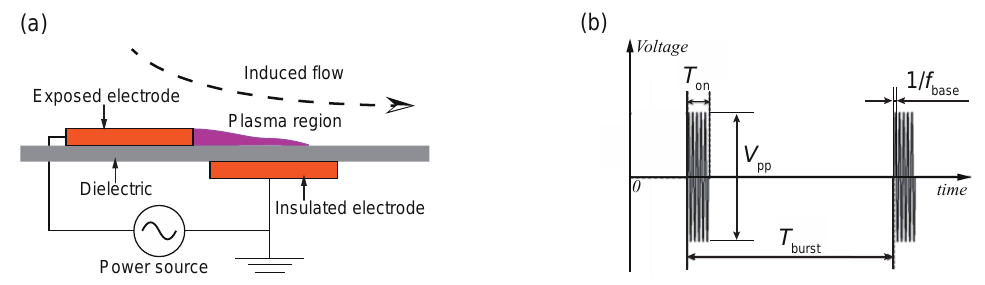
Figure 1. Schematic diagram of a typical-type dielectric barrier discharge plasma actuator (DBD-PA) ( a ) and waveform of input voltage under burst modulation ( b ).